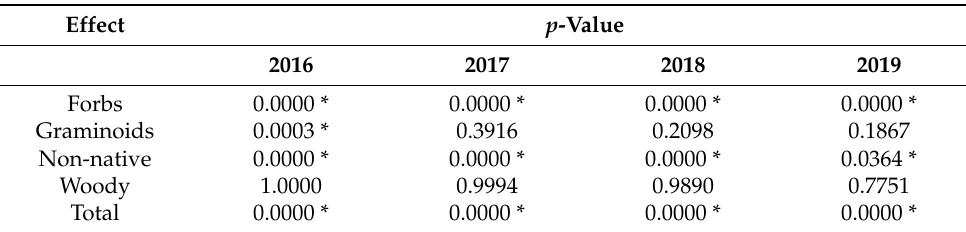
Table 1. Results of Analysis of Deviance tests for treatment effect on functional group species richness. The asterisk (*) indicates a statistically significant effect ( p < 0.05).